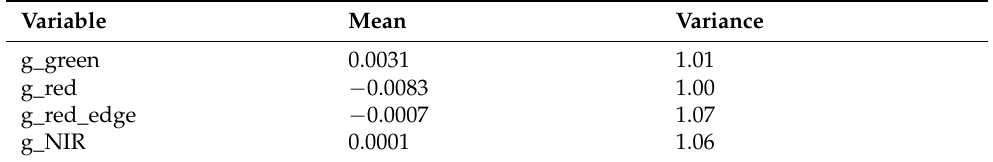
Table 3. The results of cross-validation for fitting of point LMC of the Gaussian-transformed drone reflectance variables. g before the band name stands for the Gaussian-transformed drone